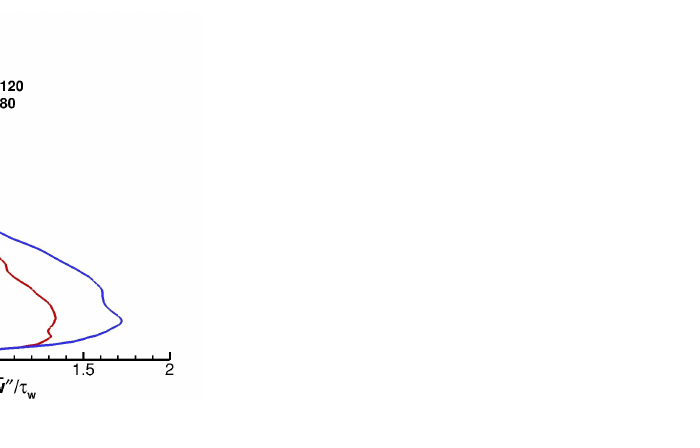
Figure 21. Morkovin scaled dimensionless turbulent normal stress at x / δ = 20 for condition No. 2 for two grids with 80 and 120 cells in the wall normal direction inside the boundary layer: ( a ) Streamwise stress. ( b ) Wall normal stress. ( c ) Spanwise stress.